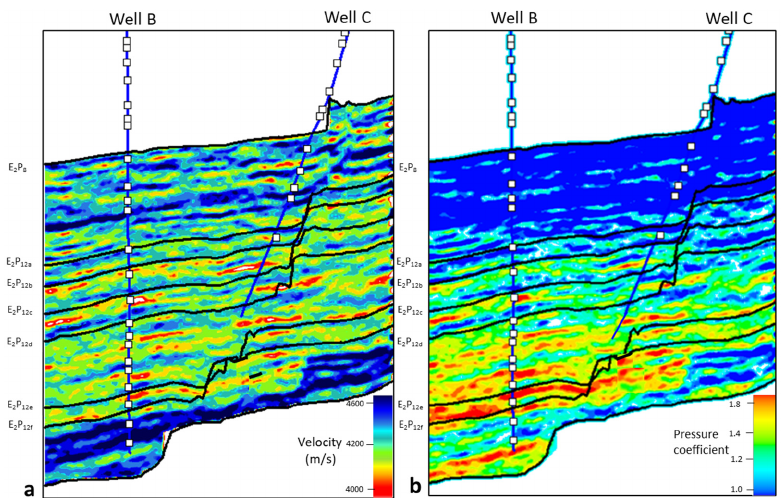
Figure 12. Cross-well section. ( a ) Velocity by seismic inversion. ( b ) Pressure coefficient by the Fil- lippone method. Fillippone